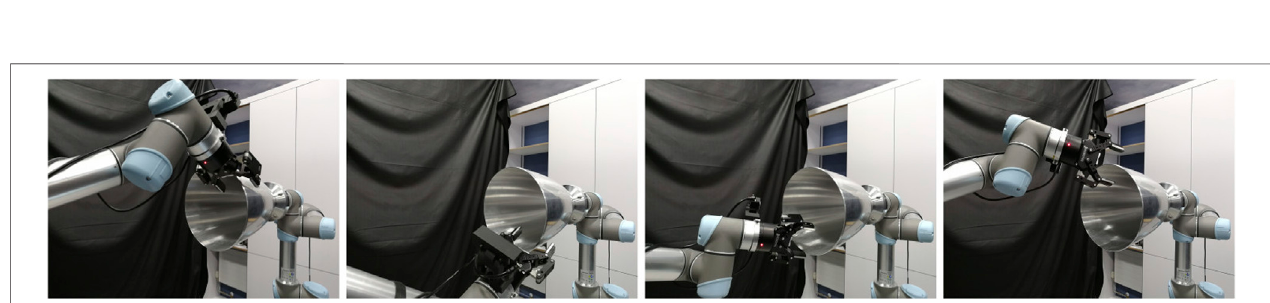
FIGURE 13 | The four grasps generated by running the grasp synthesis algorithm of Mavrakis and Gao (2019).